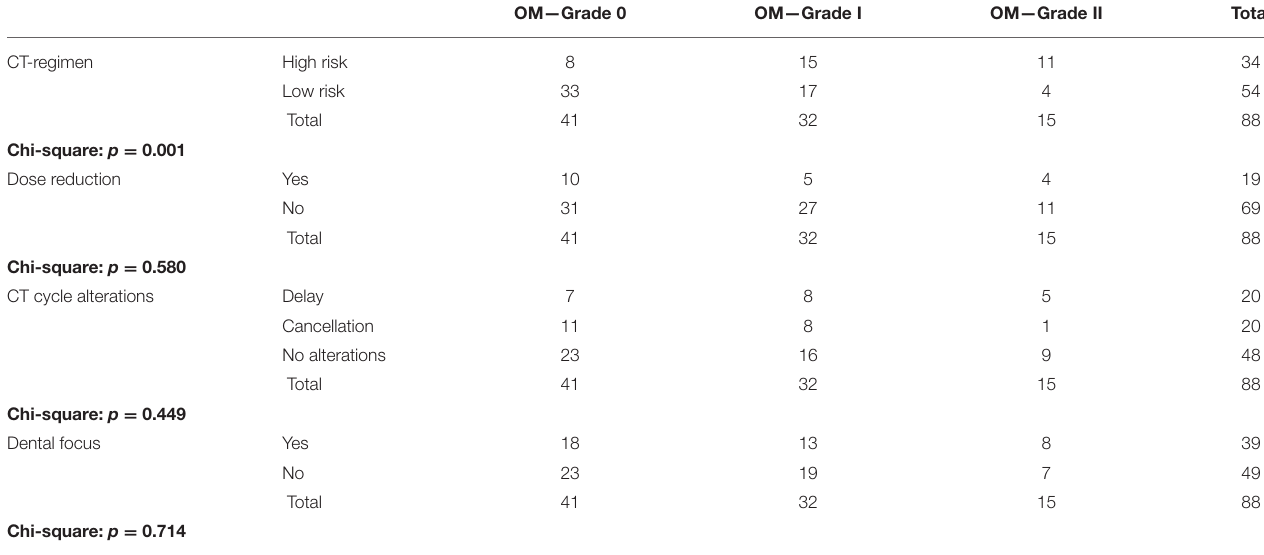
OM—Grade 0 OM—Grade I OM—Grade